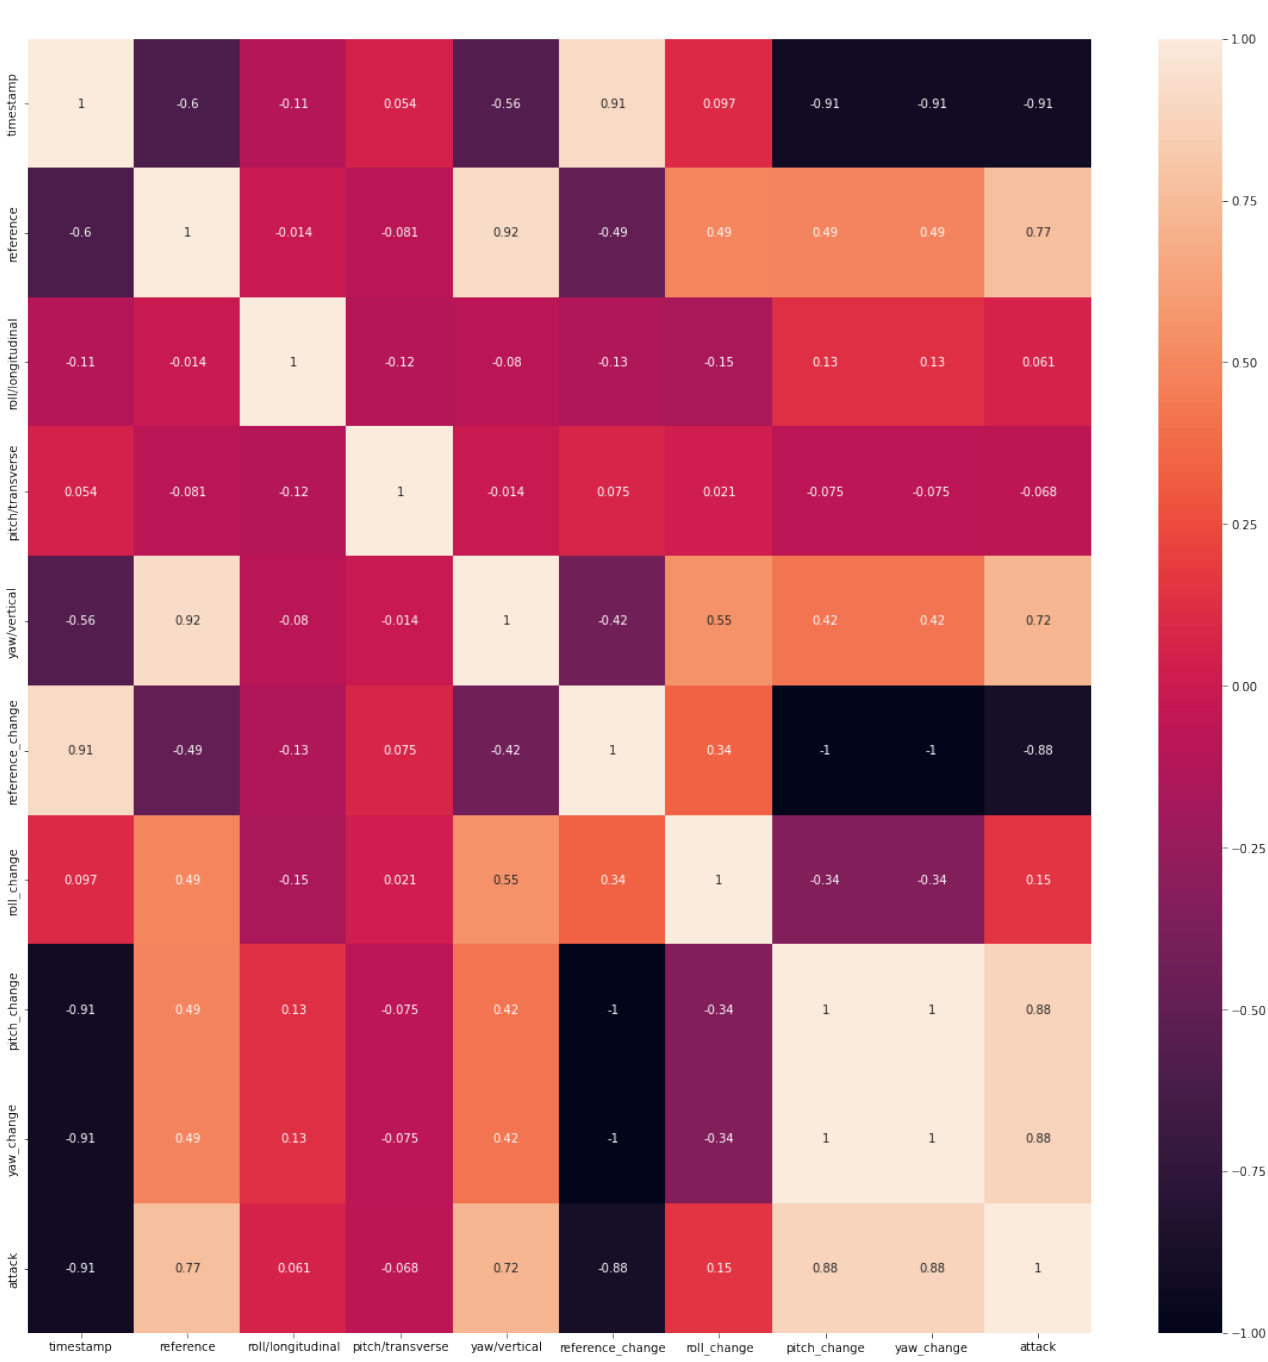
Figure 4. Correlation matrix between attacks (spoofing or jamming) and UAM attitude control pa-